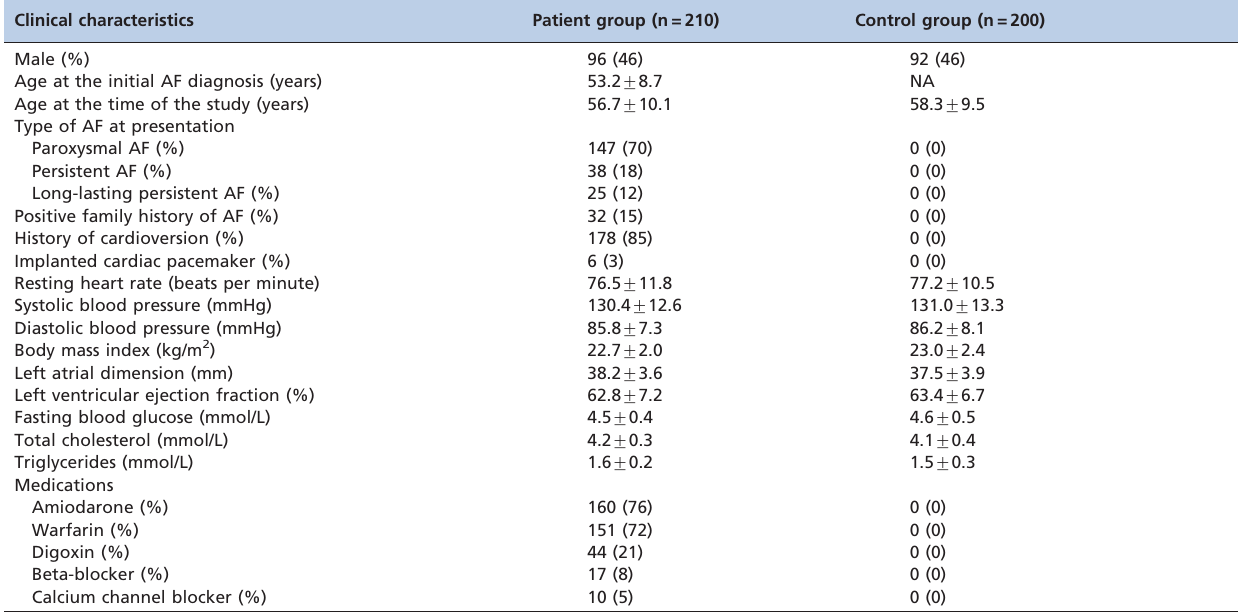
Table 2 - Baseline clinical characteristics of the study subjects.* Clinical